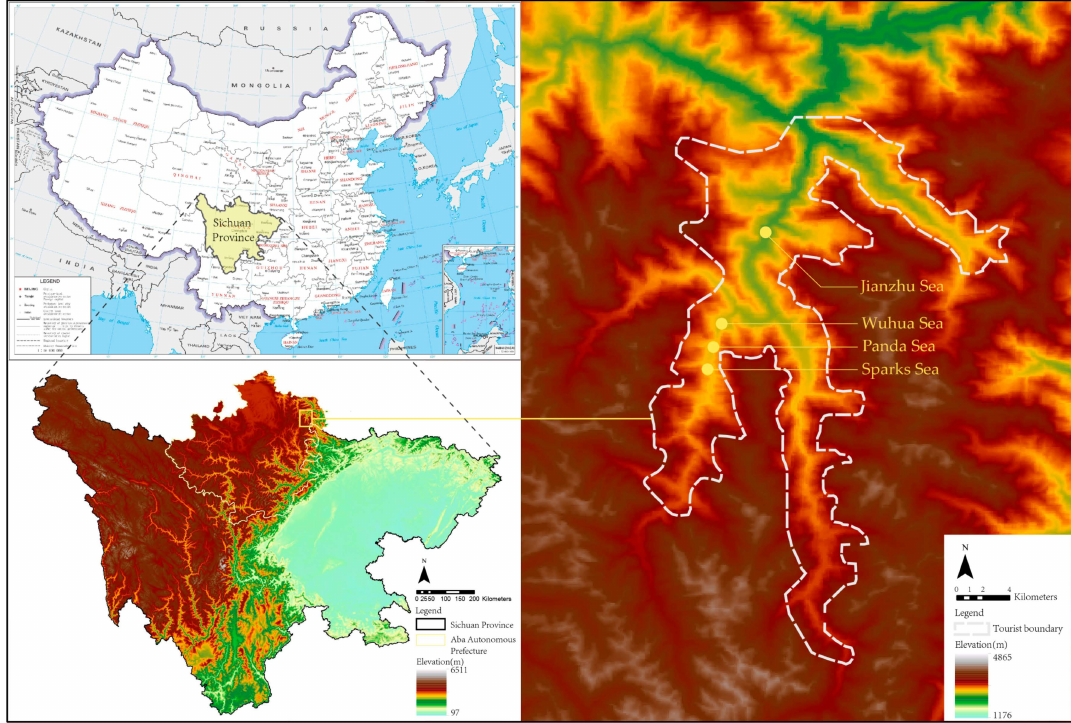
Figure 1. Schematic diagram of the study